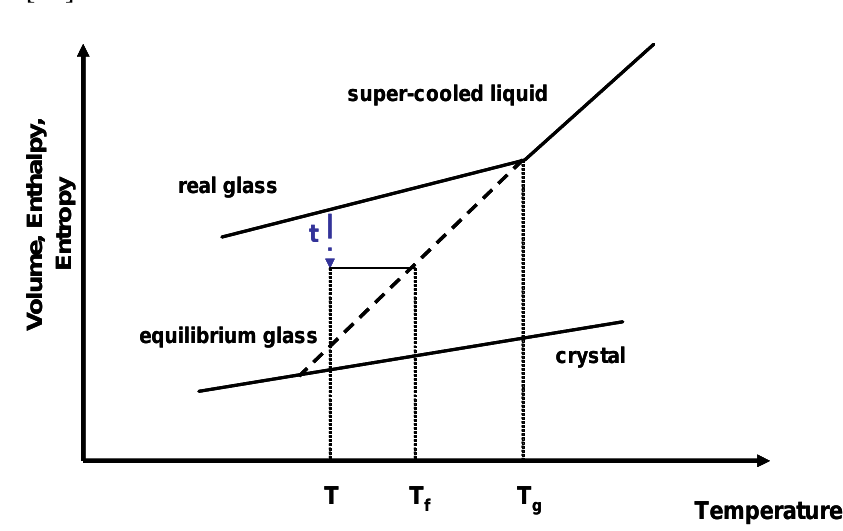
Figure 3. Relationship of enthalpy and temperature for an amorphous